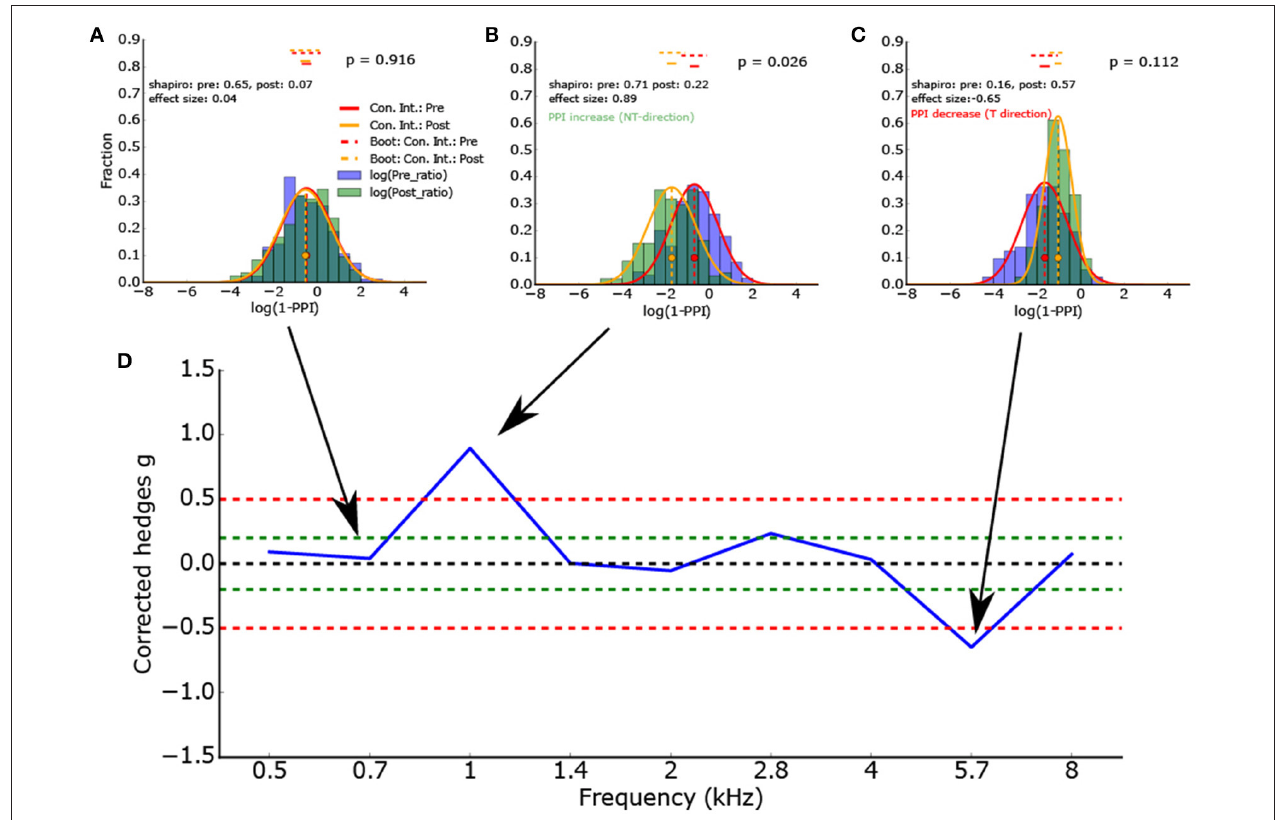
FIGURE 4 | (A–C) Histogram of the logarithmized ratios of gap and no-gap amplitudes (full combinatorial) for different center frequencies (0.7, 1.0, and 5.7kHz) of the band noise presented. As the ASR amplitude ratios are almost lognormal distributed, the logarithmized values are Gaussian-like distributed. Application of the Shapiro-Wilk test proves that the normal distribution is a valid description of the data. The red and orange vertical lines show the full combinatorial 95% confidence intervals. The dashed vertical line show the 2.5–97.5% quantile of the means calculated via bootstrapping. The size of the bootstrapped data sets was the minimum of the number of peak-to peak amplitudes of gap and no-gap measurement. In other words the bootstrapped data sets provide the upper limit of the variance of the determined means (the confidence intervals). (D) To determine the PPI change, the corrected effect size is used (n1, n2 same sample size used for statistics). To test if the distributions differ significantly, inferential statistics were applied. However, as the ASR amplitude ratios arise from all combinations of gap and no-gap amplitudes, it is possible that the number of independent ASR amplitude ratios is